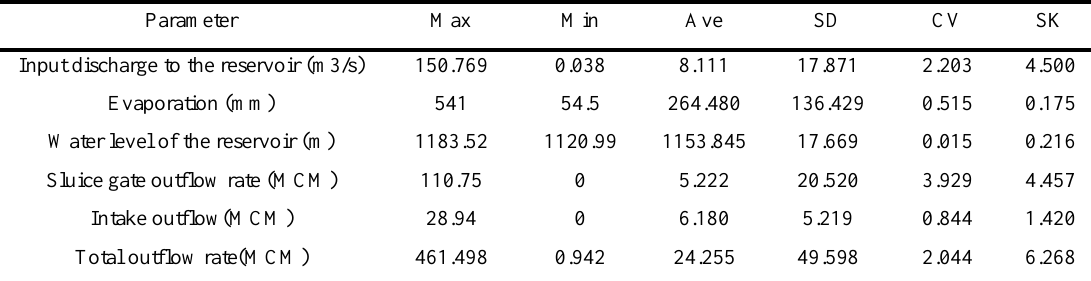
Table 2 - Statistical analysis of input parameters of data driven